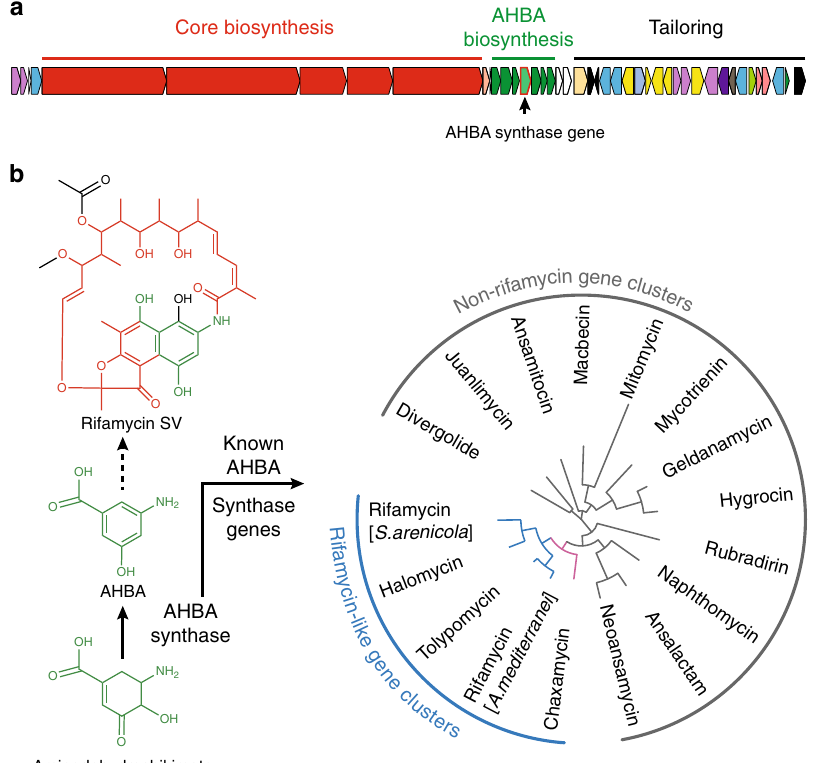
Fig. 1 The rifamycin biosynthetic gene cluster and the role of AHBA synthase. a The rifamycin gene cluster from Amycolatopsis mediterranei . b The reaction catalyzed by AHBA synthase and the structure of rifamycin SV (the product of the rifamycin gene cluster). The rifamycin SV structure is colored according to the genes responsible for producing its PK core (red), AHBA-derived substructure (green), and tailoring functionalities (black). The phylogenetic divergence of AHBA synthase genes from previously characterized gene clusters correlates with the different structural classes of